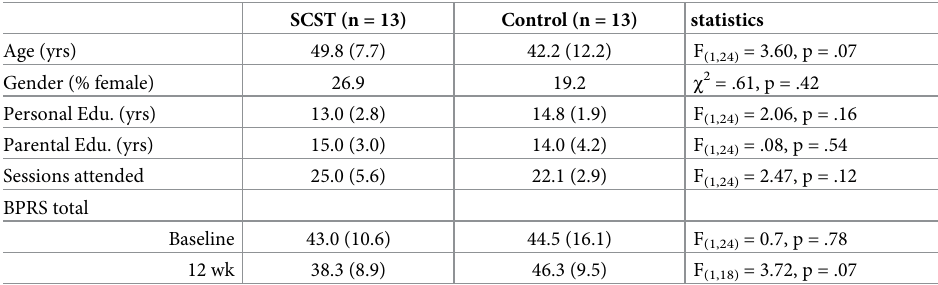
Table 1. Demographics, clinical characteristics and Attendance data of